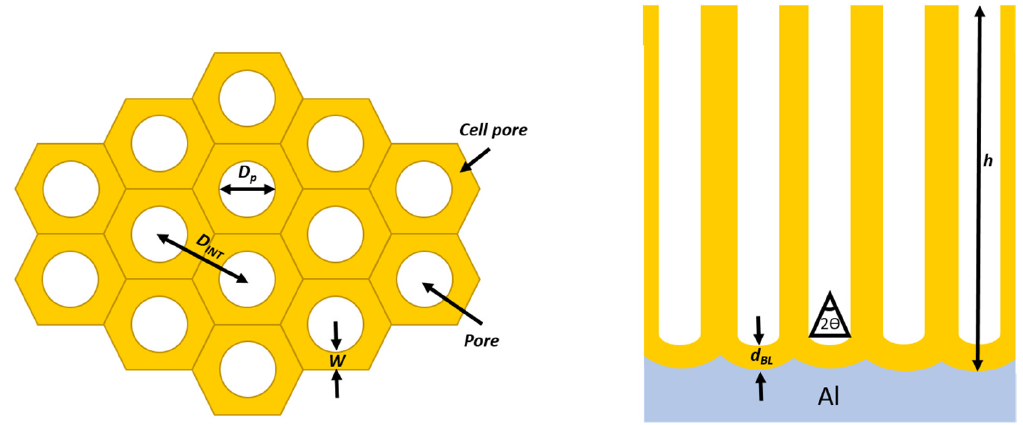
Figure 5. Main geometrical features of a PAA template.